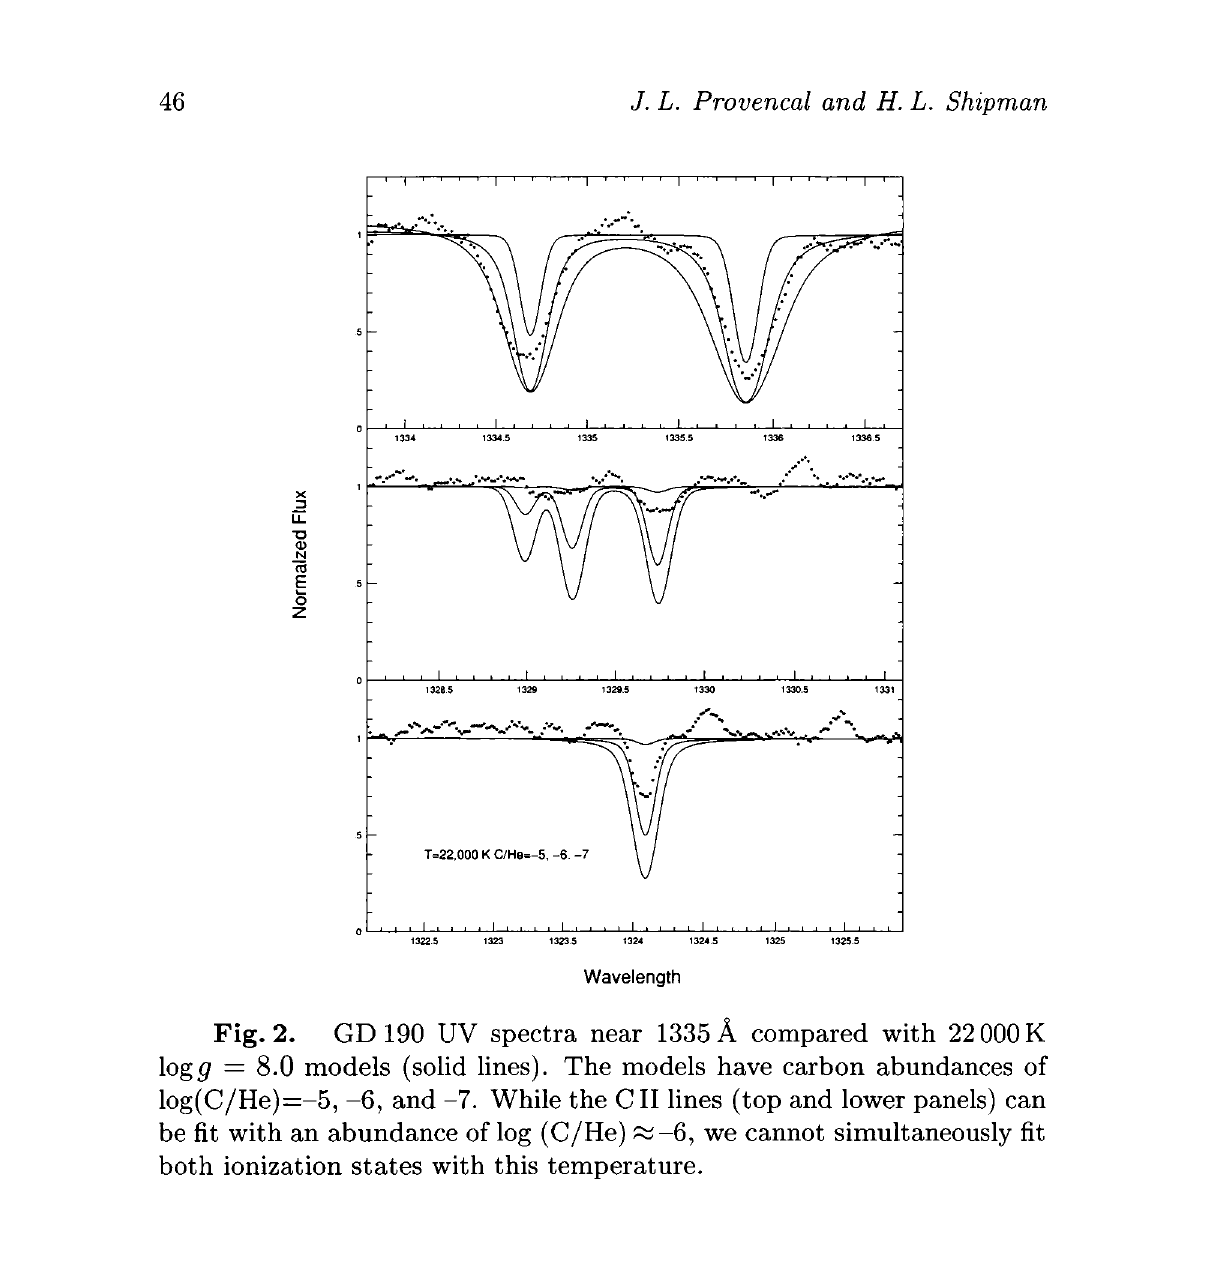
Fig. 2. GD 190 UV spectra near 1335 A compared with 22 000 K log<7 = 8.0 models (solid lines). The models have carbon abundances of log(C/He)=-5, -6, and -7. While the CII lines (top and lower panels) can be fit with an abundance of log (C/He) ~ - 6, we cannot simultaneously fit both ionization states with this